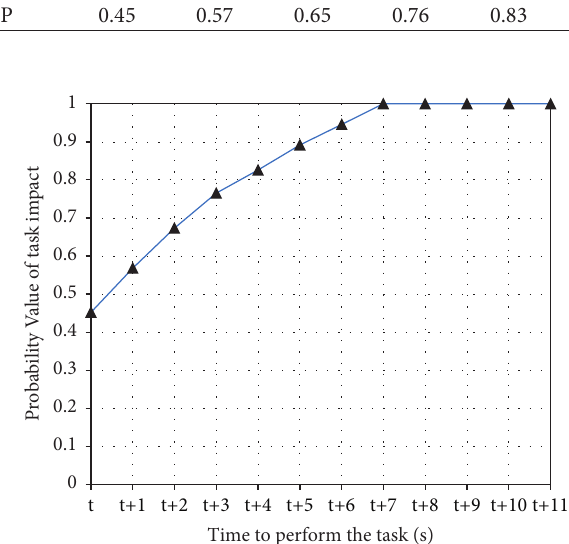
Figure 9: Threat level curve of the insufficient energy margin event to UUV